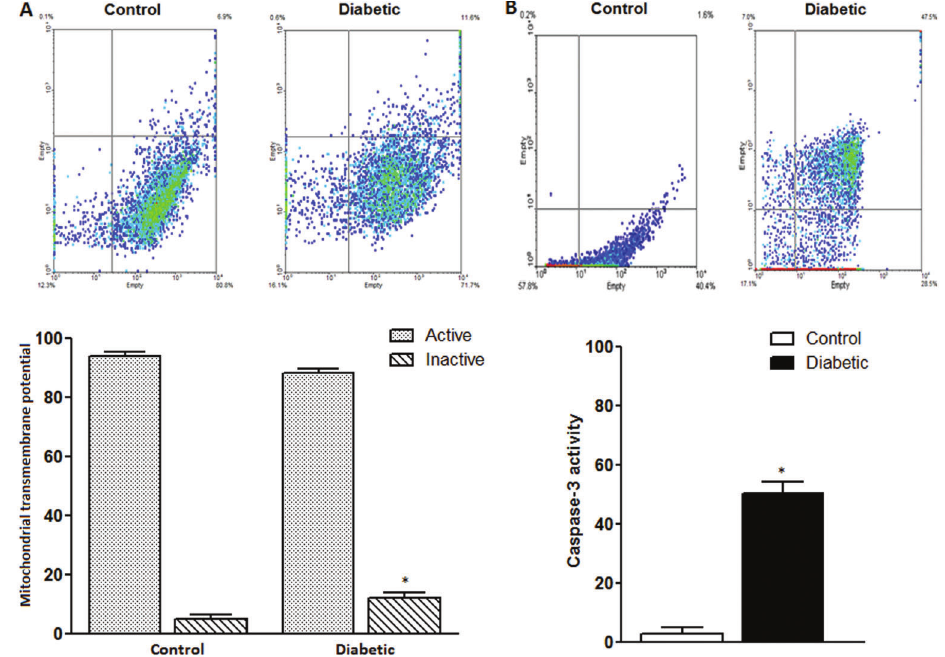
Figure 2. A , Flow cytometry plots of visceral yolk sac (VYS) cells from control and diabetic groups stained with rhodamine 123. The histograms show an increased number of VYS cells with inactive mitochondria (unviable cells) in the diabetic group and a similar number of cells with active mitochondria (viable cells) in both groups. B , Representative fl ow cytometry plot of activated caspase-3 in VYS cells of control and diabetic groups. The histogram shows a large number of activated caspase-3-expressing VYS cells in the diabetic group. Results are reported as the means ± SE of VYS cells collected from fi ve yolk sacs per animal of the control (n=5) and diabetic groups (n=5) analyzed in duplicate. *P o 0.05 (Student ’ s t -test).